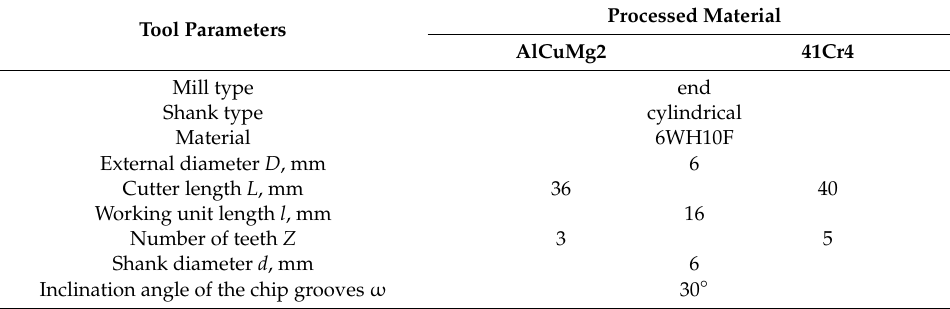
Figure 2. Design of end mills used in research. Table 3. Design and geometric parameters of end mills.